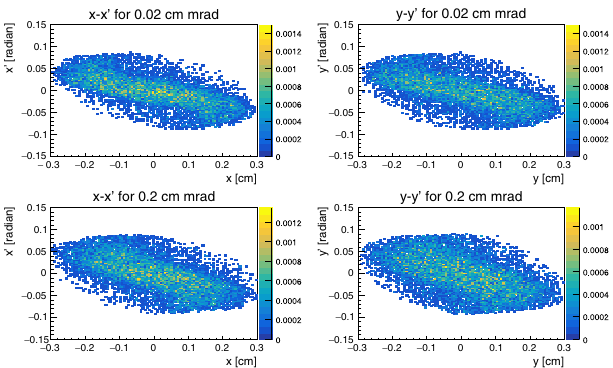
FIG. 8. Scatter plot for the phase space distribution of deuteron beams at the RFQ entrance. The top two figures correspond to the simulation result with normalized emittance of 0.02 cm mrad, whereas the bottom two figures correspond to that with 0.2 cm mrad. These scatter plots are created by the number of MC events of 10,000 of LEBT beam simulation conducted with RFQGen software and the integrated numbers of them are normalized to be 1. These histograms are divided with 100 × 100